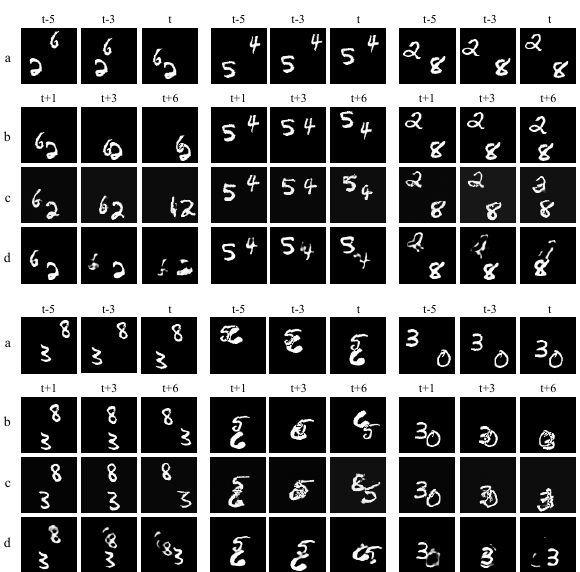
Figure 4. Prediction results for the MovingMNIST test